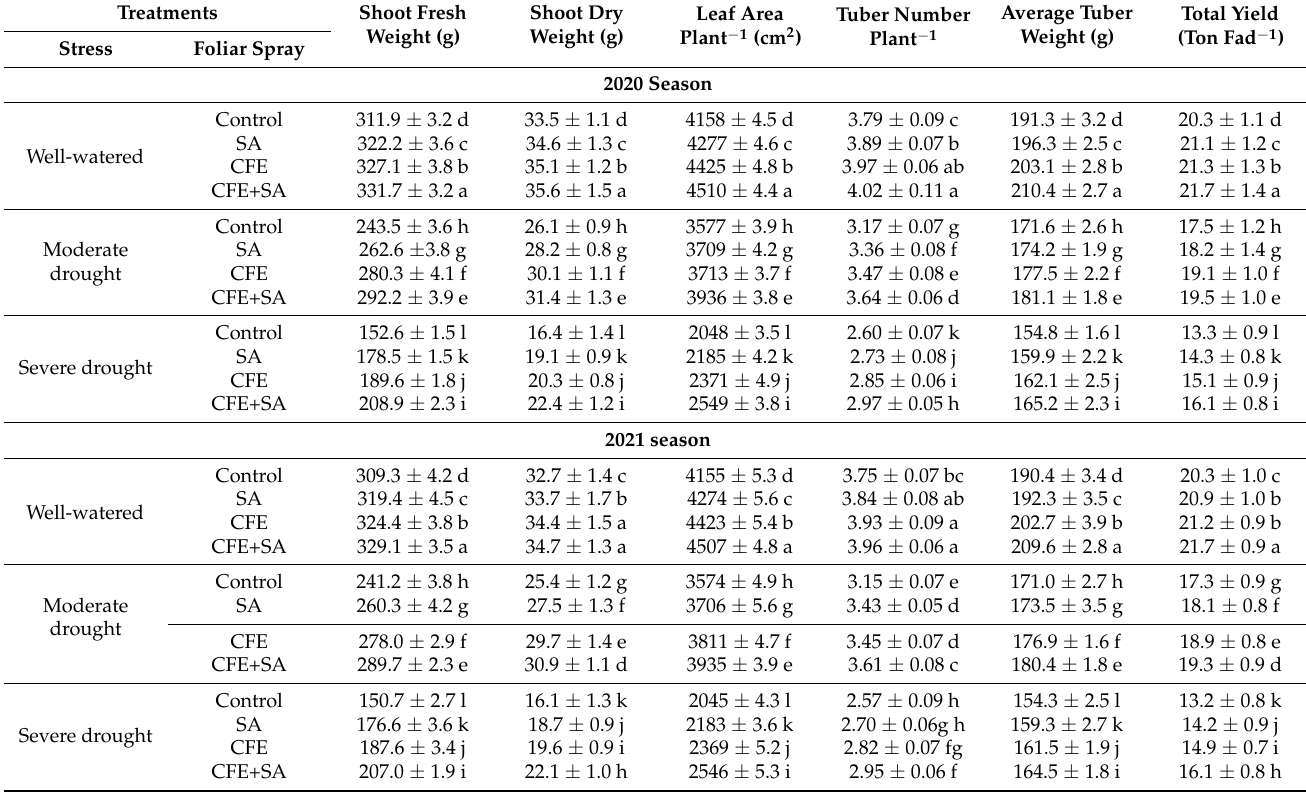
Table 3. Influence of foliar nourishment with clove fruit extract (CFE) and salicylic acid (SA) on growth traits and yield component of potato plants grown under three irrigation regimes in two seasons.